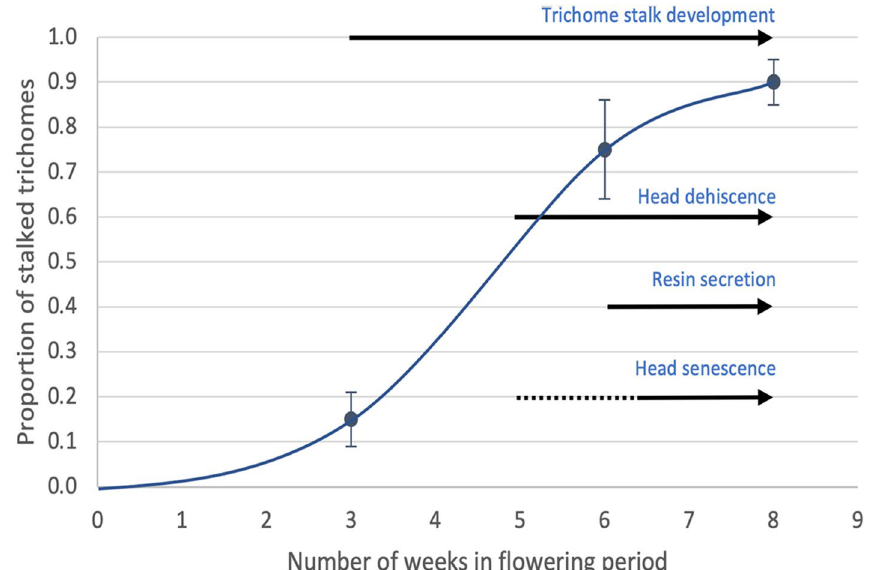
Fig. 11 Schematic representation of the progression of capitate trichome development and senescence in cannabis genotypes MD and SQ based on the observations made in this study. The proportion of stalked-capitate trichomes increases exponentially with time in the flowering period to a maximum at 8 weeks. The process of glandular head dehiscence, secretion of resin and senescence begins at around 5 weeks and progresses to harvest (8 weeks). The timelines depicted here will vary by genotype as well as environmental conditions that impose stresses on the plant, which could accelerate the process of glandular head dehiscence and